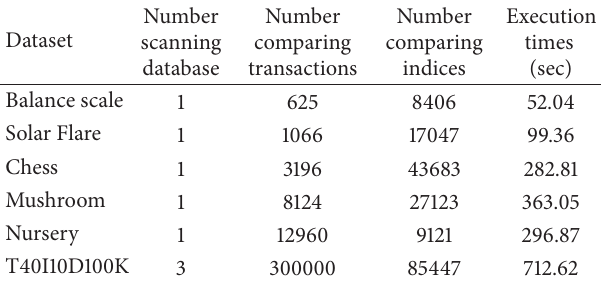
Table 5: The averages of several results for IUARMMEA.